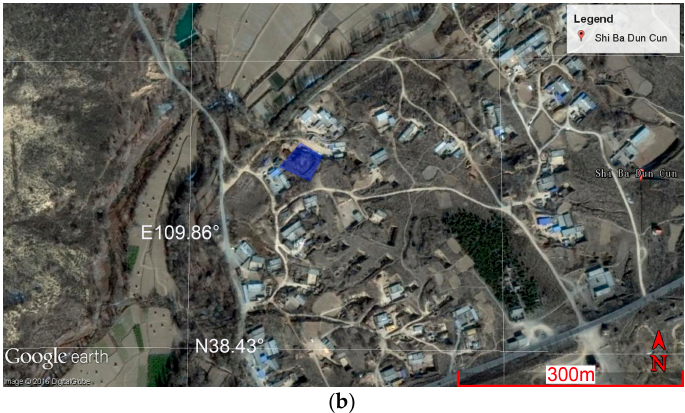
Figure 7. Maps of the study areas ( a ) Erlou Cun (22 April 2012, photos from Google Earth), the scanned area is in light blue and is about 348 m 2 ; ( b ) Shiba Dun Cun (12 February 2015, photos from Google Earth), the scanned area is in light blue and is about 225 m 2 .